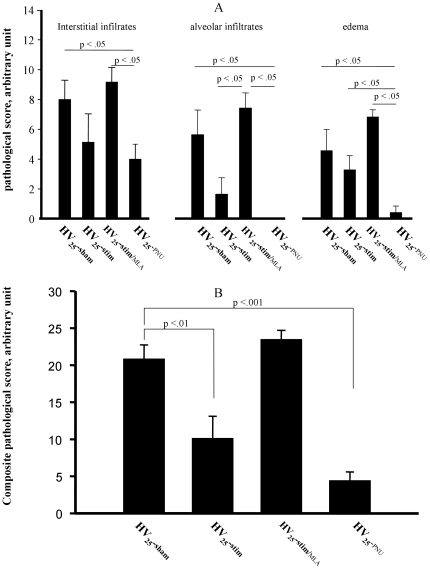
Lung injury scores in rats exposed to high stretch ventilation.Panel A represents individual score, panel B represents composite score. HV25-sham: injurious ventilation and saline injection; HV25-PNU: pre-treated with alpha7 nicotinic acetylcholine receptors agonist PNU; HV25-stim: associated with vagal stimulation; HV25-stim/MLA: associated with vagal stimulation and pre-treatment with alpha7 nicotinic acetylcholine receptor blocking agent MLA. Data are expressed as mean ± SEM. Levels of significance are indicated on the graph.